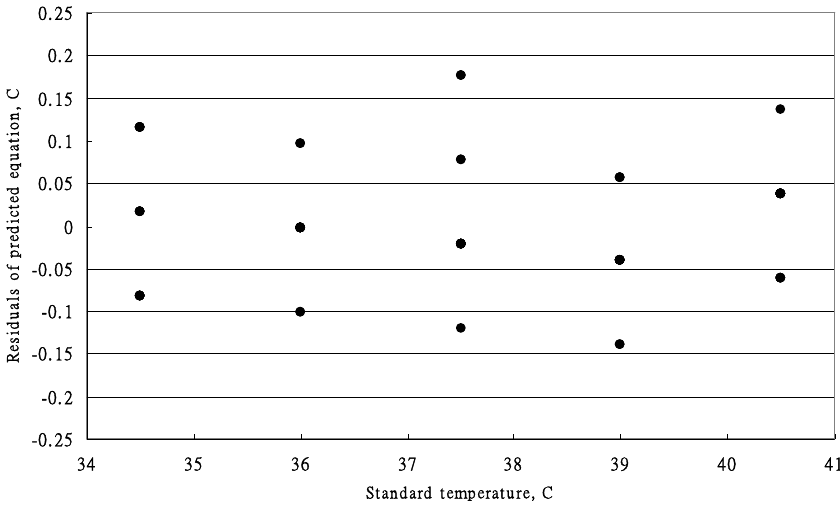
Figure 6. The predicted errors of calibration equation of BRAUN IRT-3020 thermometer.